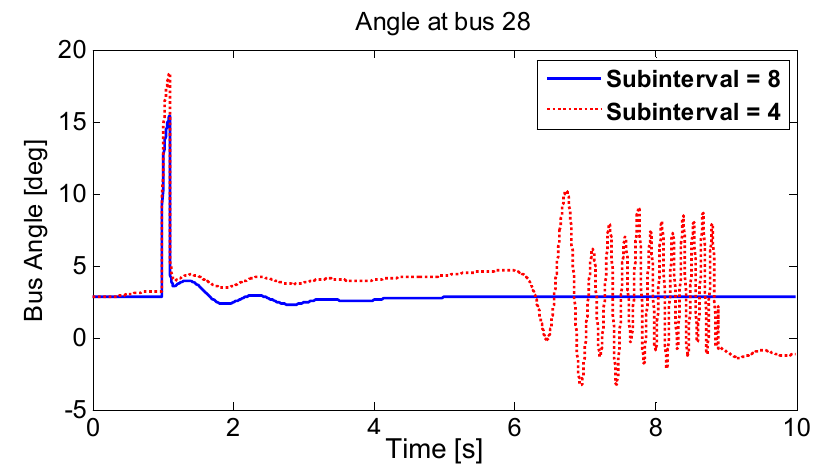
Figure 7. Simulation comparison between four and eight subintervals: ( a ) Voltage magnitude; ( b )